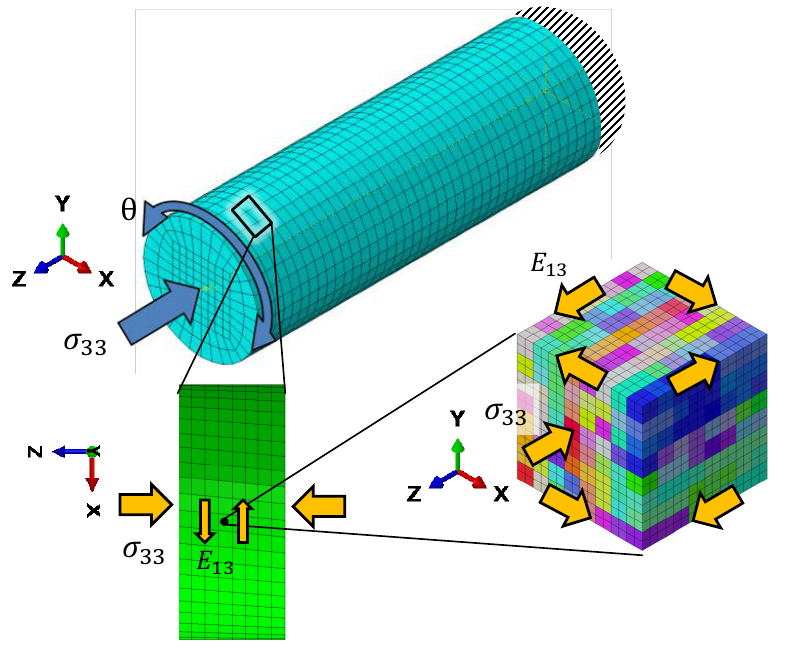
Figure 9. To mimic HPTF loading conditions on the length scale of the RVE used for CPFEM sim- ulations, the distortions of a small volume element close to the surface of the cylindrical FE model, representing the gauge section of the HPTF specimens, are applied as boundary conditions to the